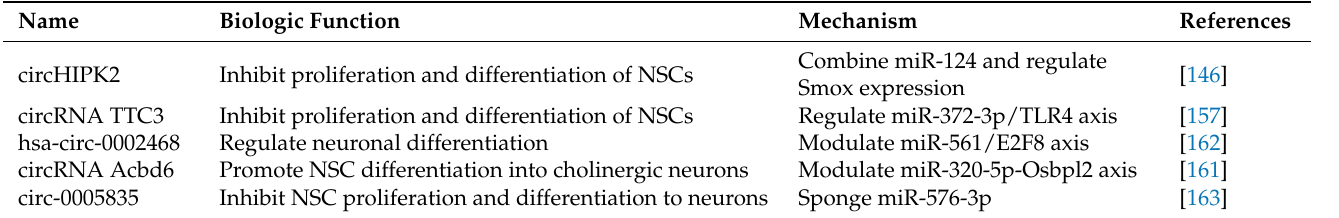
Table 3. Effects and mechanisms of various circRNAs in